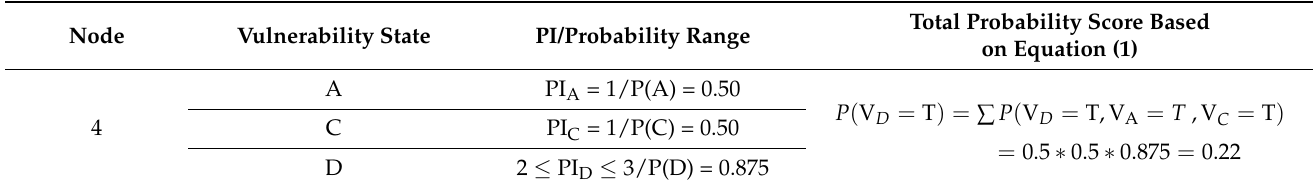
Table 6. Example of calculation of PI and total probability score, for Node 4. Node Vulnerability State